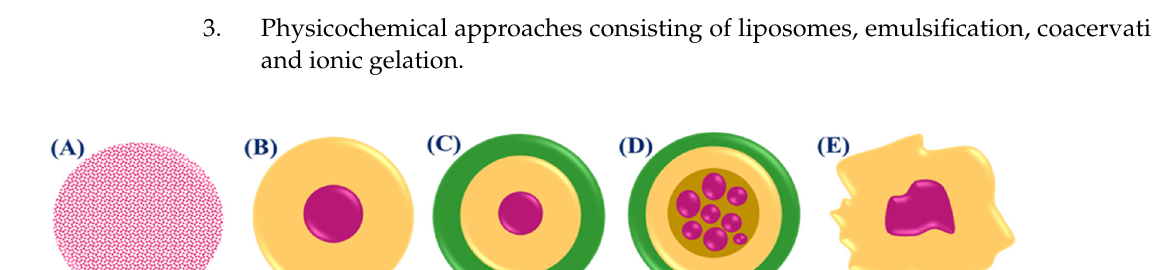
Table 1. Overview of the advantages, disadvantages, and variable parameters of various microencapsulation methods. Method